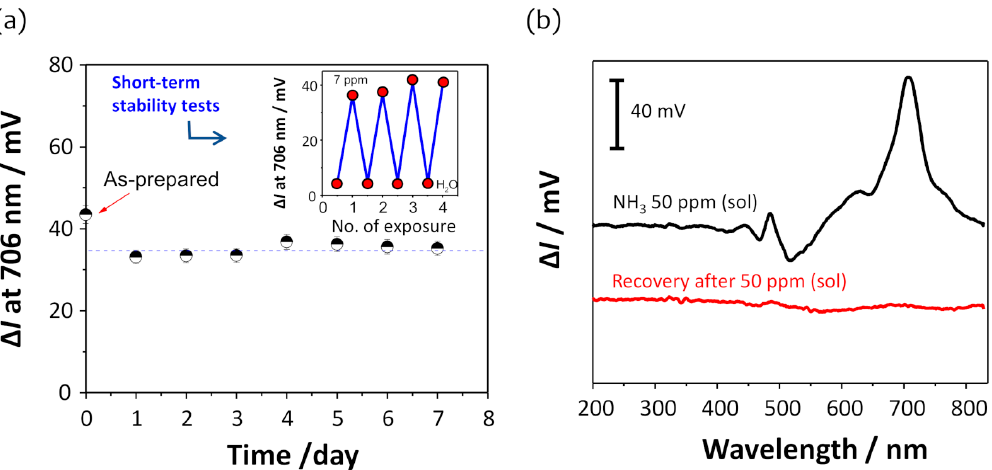
Figure 7. ( a ) Long-term stability of the sensor response due to the repeated exposure ( n = 5) to 7 ppm (sol) ammonia over seven days. The inset shows repeatable switching of intensity changes obtained in a series of repeated ammonia exposure experiments in a short period of time. ( b ) Intensity changes in the transmission spectra due to the exposure of the U-bent OFS to 50 ppm (sol) ammonia and after flushing with dry